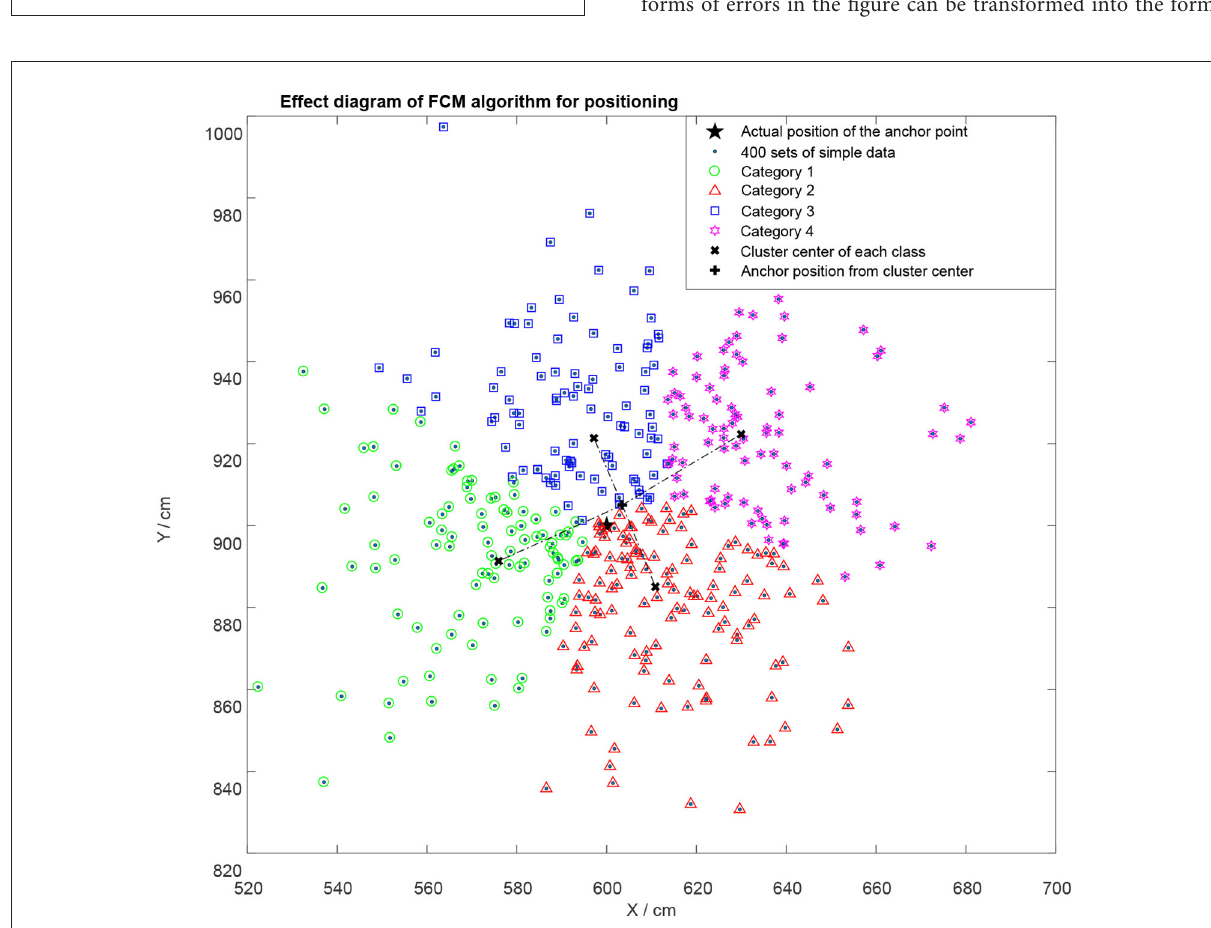
FIGURE6 A representation of the four classification effects of FCM